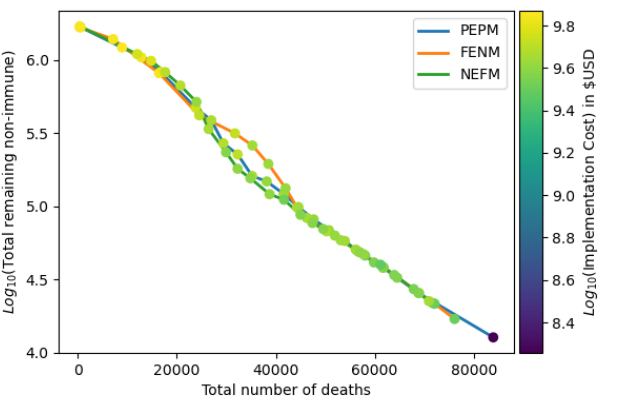
Figure 2. Pareto curves showing the trade-off between total deaths and final herd immunity level, for the three different algorithm variants. Solutions are given by colored dots, where dot colors indicate the solution implementation cost according to the color scale at right.